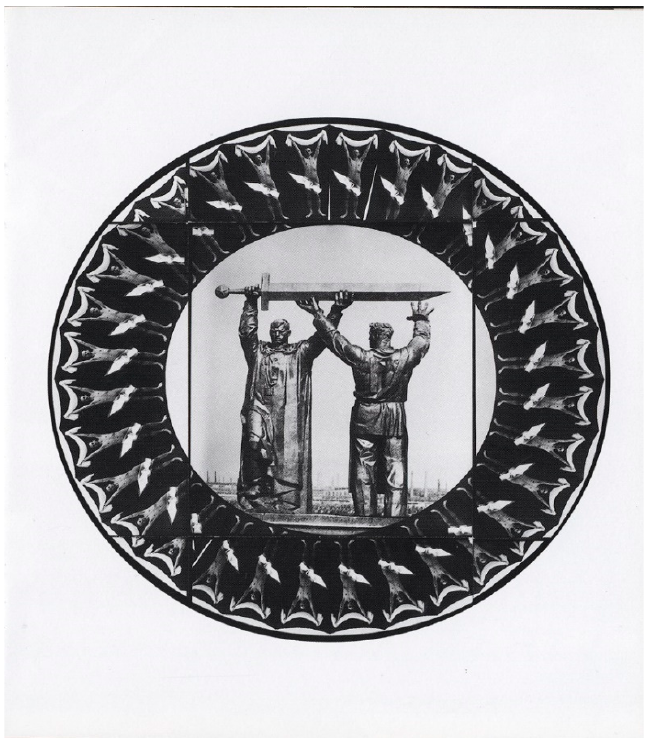
Figure 2. Kulik, All the Missiles are One Missile , guide, 1997. Vera Isaeva with Robert Taurit, Mother